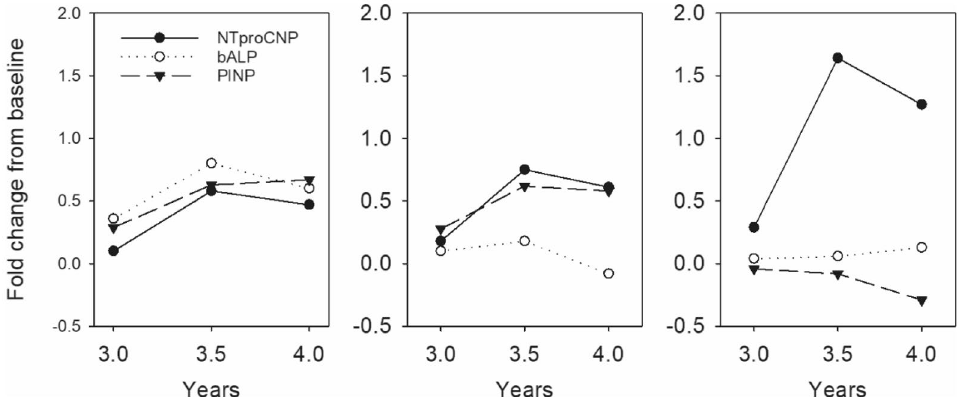
Figure 2. Fold change from baseline (screening) in bone turnover markers (bALP, PINP) and plasma NTproCNP in three Cohort 4 subjects in years 3–4 of therapy. Each panel depicts concurrent analyte concentrations in a single subject.